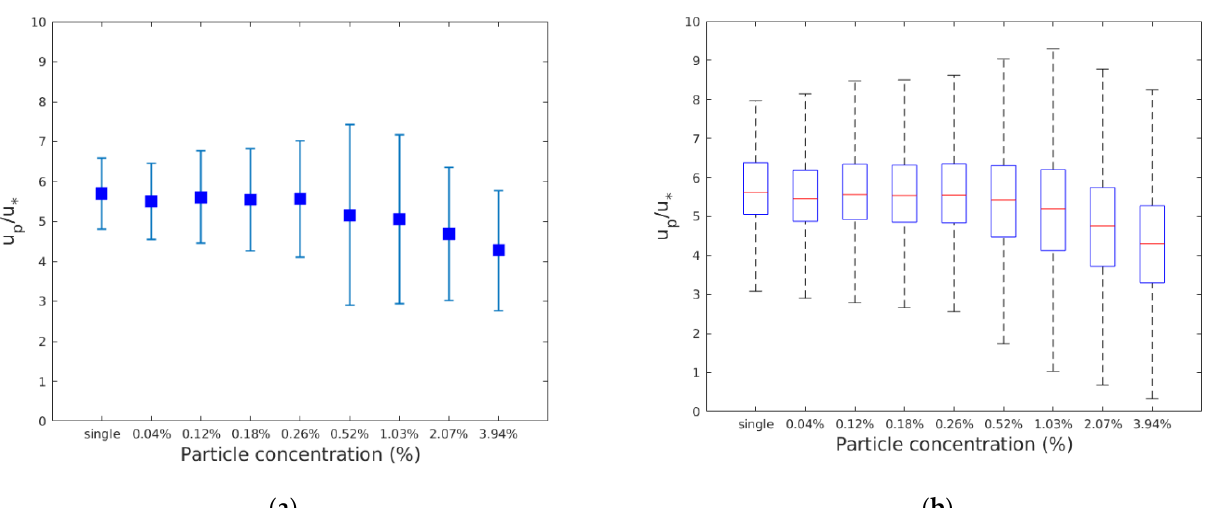
Figure 6. Change of dimensionless particle velocity for a single particle and different particle concentrations. ( a ) Mean dimensionless particle velocity (blue square), where vertical blue lines represent two standard deviations. ( b ) Boxplot of dimensionless particle velocity; the red line depicts the median, whereas the box bottom and top blue lines indicate the 25th and 75th percentiles; vertical dash lines represent the most extreme values not considering outliers.